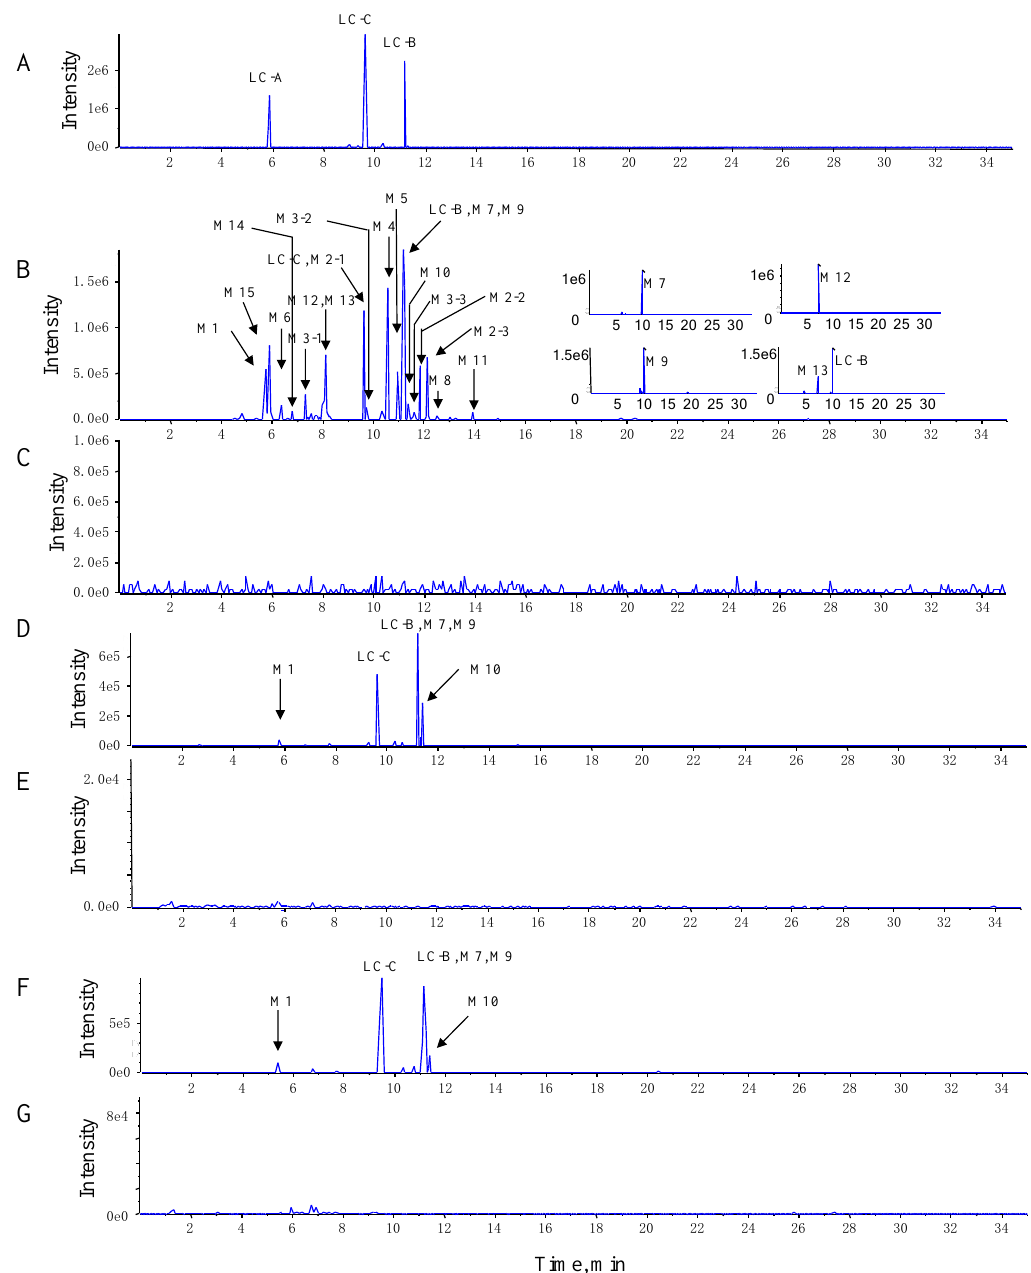
Figure 2. The representative extracted ion chromatograms (XIC) of LC-B, LC-C, and their metabolites. ( A ) The XIC of standard LC-B, LC-C, and LC-A. ( B , C ) The XIC of LC-B, LC-C, and their metabolites in pooled feces and blank feces. ( D , E ) The XIC of LC-B, LC-C, and their metabolites in pooled plasma and blank plasma. ( F , G ) The XIC of LC-B, LC-C, and their metabolites in pooled urine and blank urine.